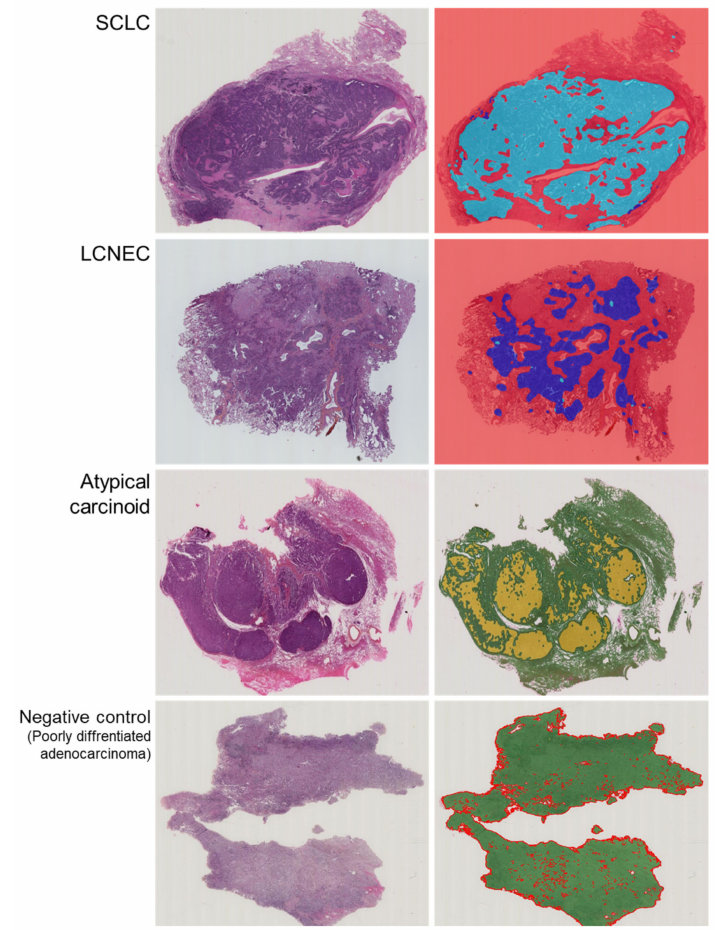
Figure 1. Representative examples of raw images of SCLC, LCNEC, AC and negative cases with an overlap of the HES slide and the corresponding probability maps obtained with the HALO-AI lung NET module trained by the pathologists.